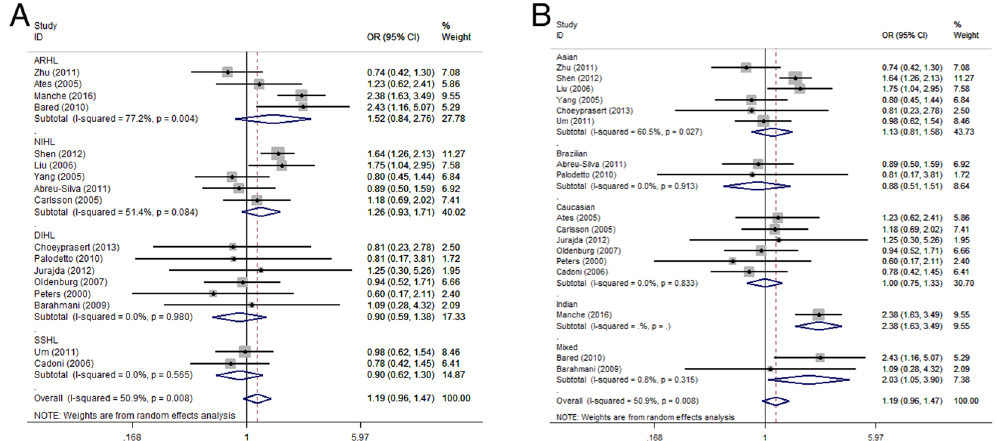
Figure 3. Subgroup analysis of the association between GST M1 and the susceptibility to acquired SNHL according to the acquired SNHL types ( A ) and ethnicity ( B ).